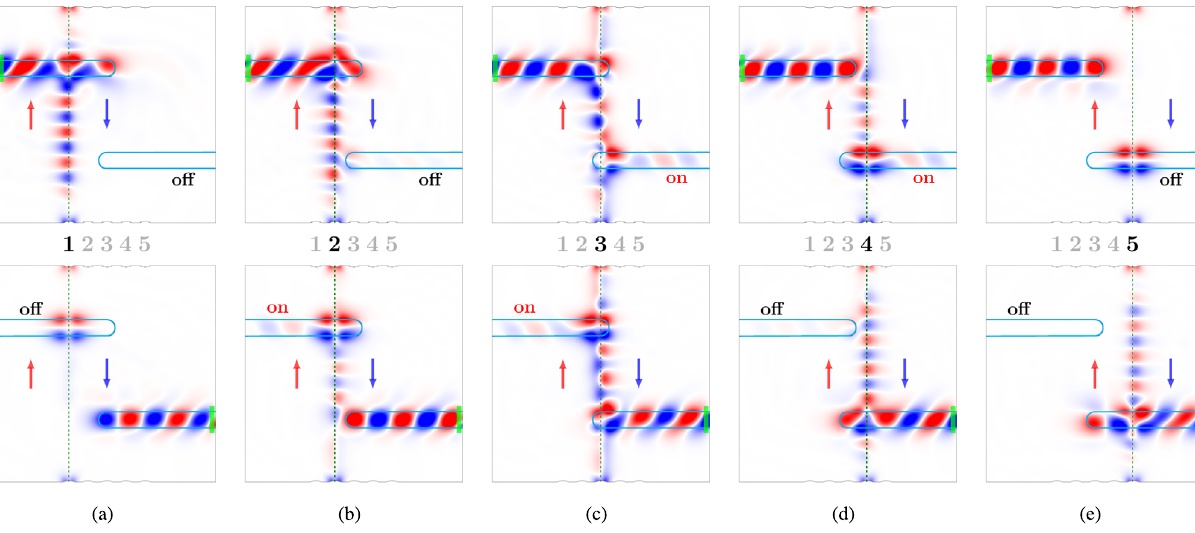
FIG. 5. Reprogramming the diode by moving the domain-wall position. The functionality is tuned by the domain-wall position (from position 1 to 5, the domain-wall center is indicated by the dashed line). The spin wave is injected from the left (right) terminal for the upper (lower) row. (a) Position 1, off in both directions. (b) Position 2, diode with the forward direction from right to left. (c) Position 3, on in both directions. (d) Position 4, diode with the forward direction from left to right, opposite to position 2. (e) Position 5, off in both directions, similar to position 1. The kinks are to pin the domain walls. The simulation is performed on a two-dimensional film of size 1600 nm × 1600 nm with an additional perpendicular anisotropy in the terminal area to mimic the EASA in three-dimensional samples. (See the movie in Ref. [24] for simulated real-time switching among these functions by current-induced domain-wall